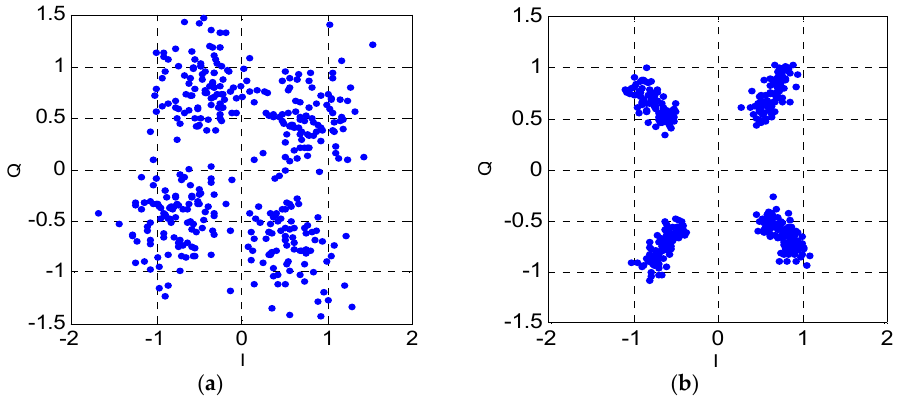
Figure 8. Impact of carrier frequency offset (CFO) on quadrature phase shift keying (QPSK) demodulated signal.